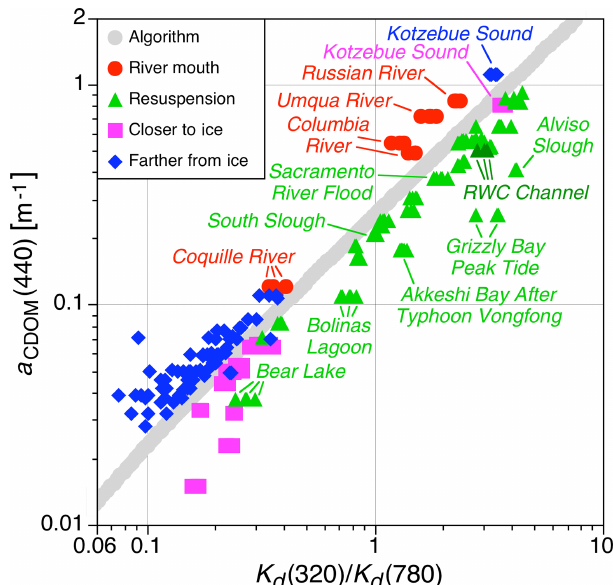
Figure 6. The new data obtained in a harbor (or marina), plus water bodies experiencing an invasive species, HAB, or atypical